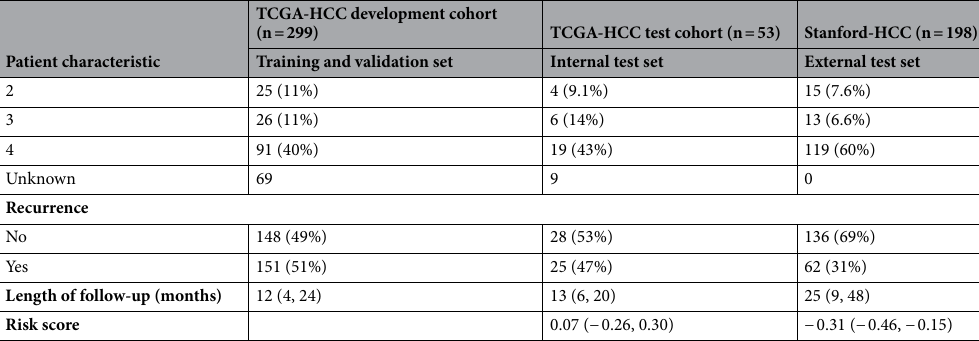
Table 1. Patient characteristics for the Stanford-HCC and TCGA-HCC datasets. Values presented: median (IQR); n (%).